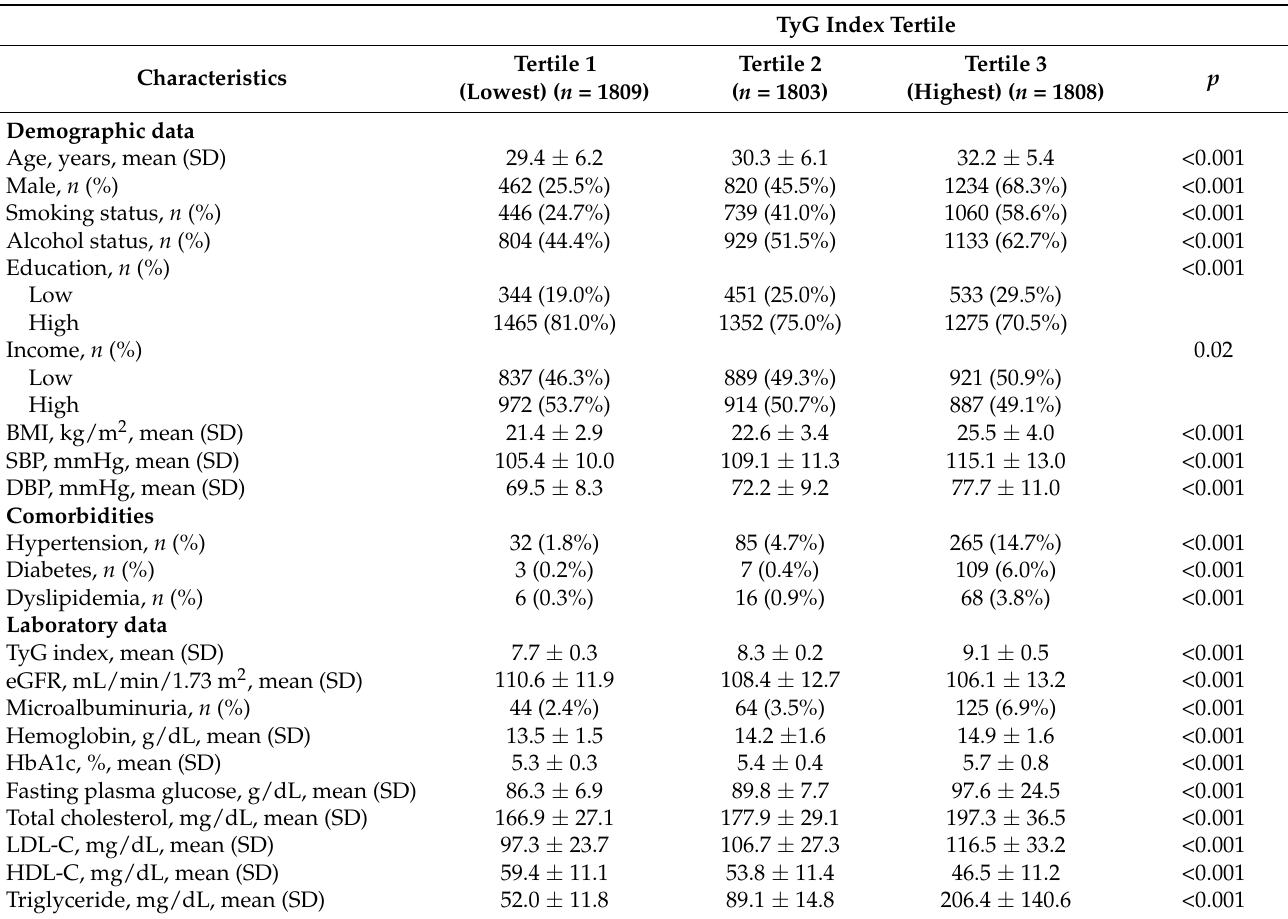
Table 1. Baseline characteristics.